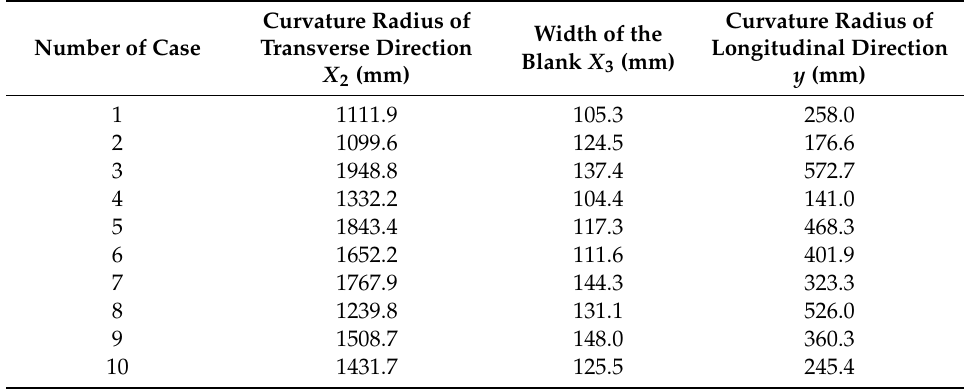
Table 8. Statistical table for the convex type random